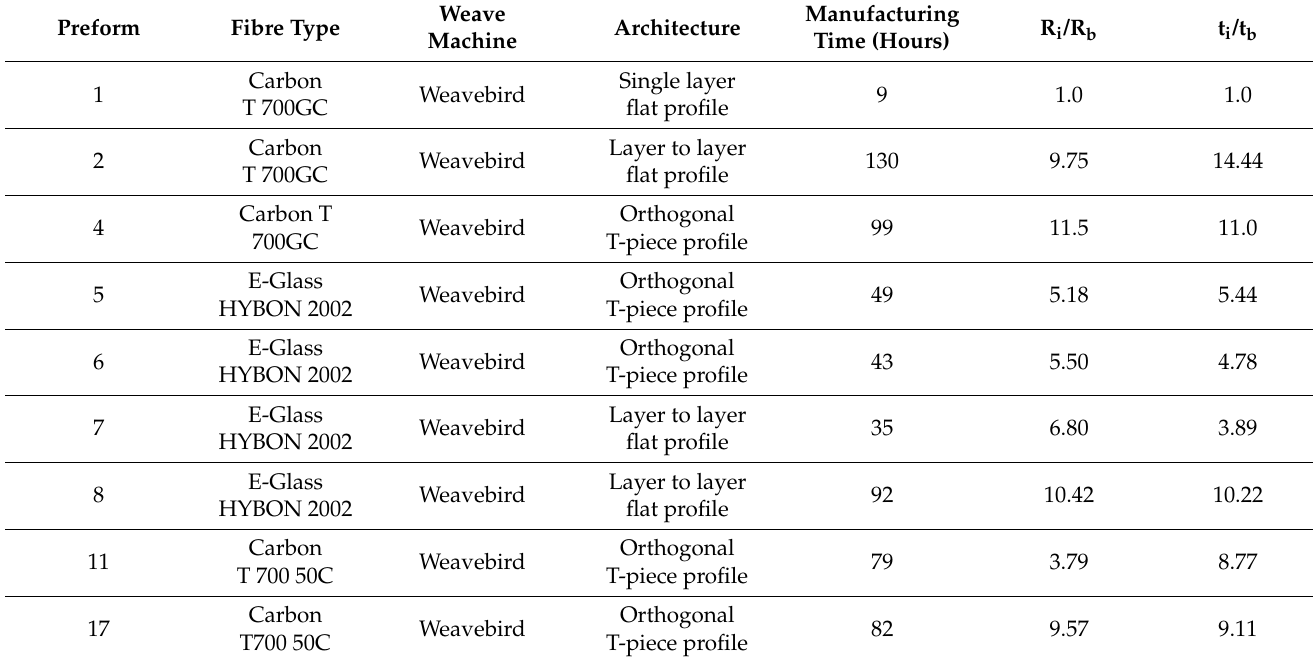
Table 3. Preforms woven on Weavebirdloom.